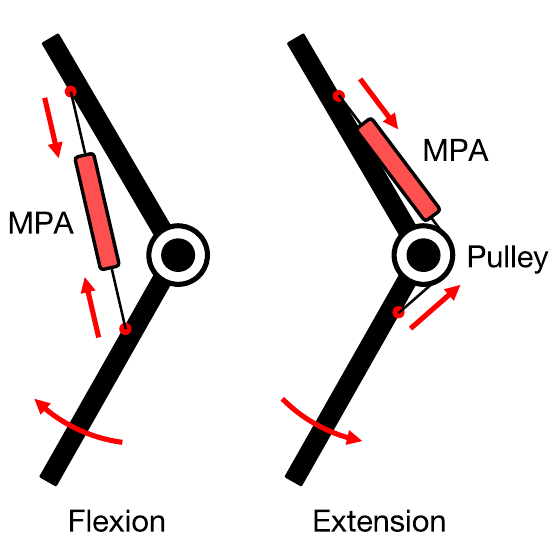
Fig. 2 Joint flexion (left) and extension (right) by MPA and